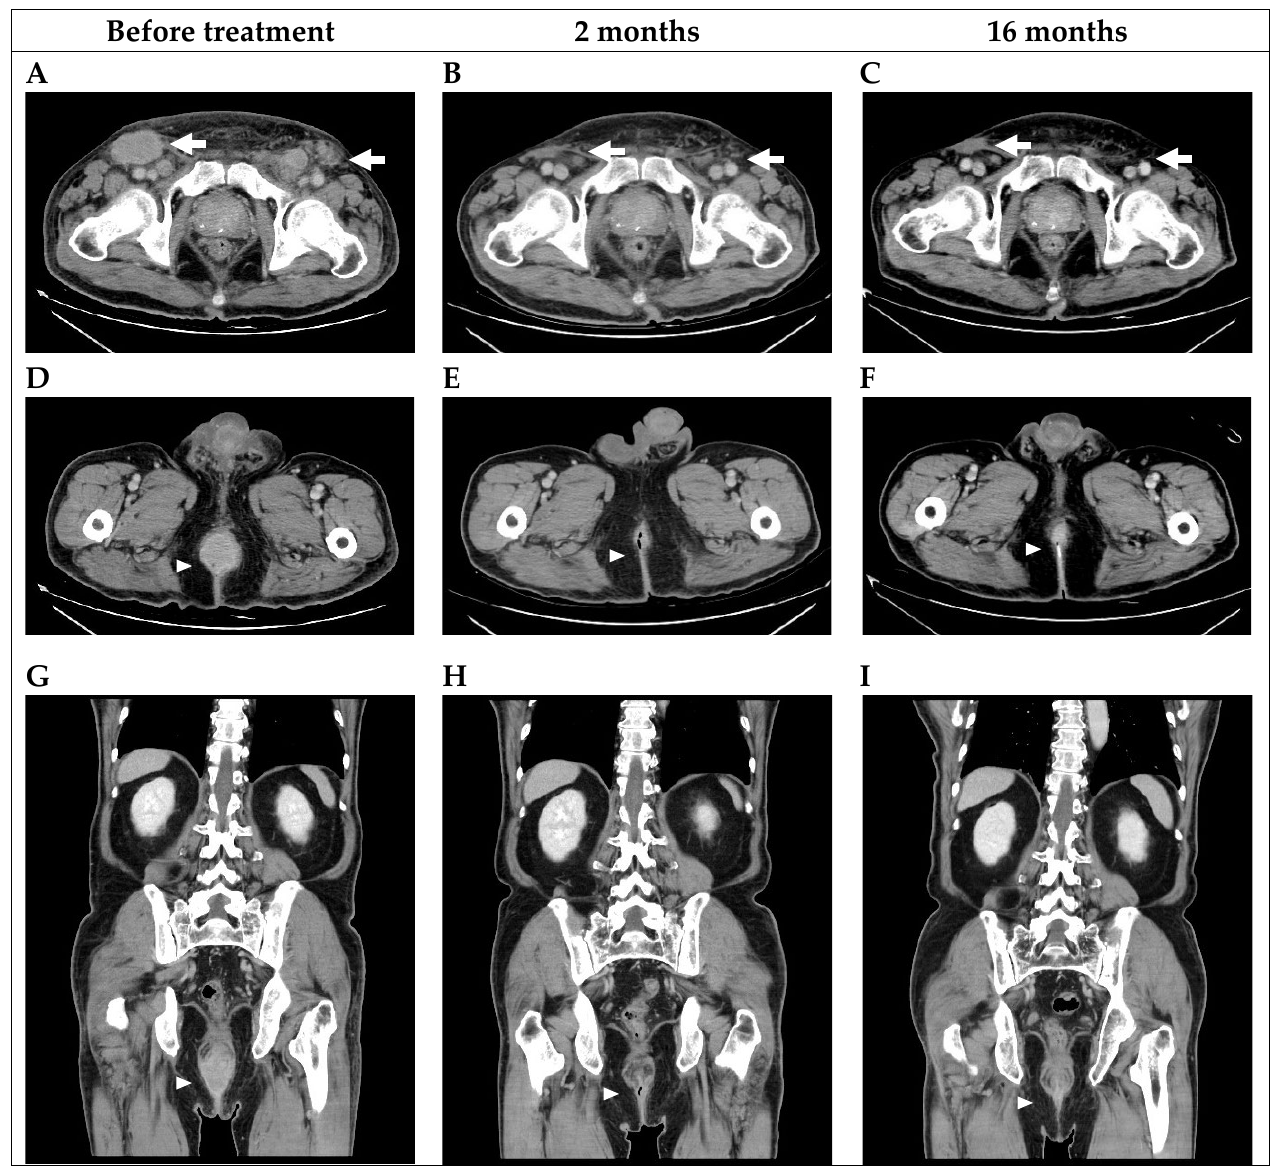
Figure 2. ( A – C ) Bilateral inguinal lymphadenopathy. Arrows: The bulky bilateral inguinal lymph nodes shrank 2 months after the combination treatment of durvalumab and chemotherapy. The effect persisted at 16 months. ( D – F ) Axial view of the rectal mass. ( G – I ) Coronal view of the rectal mass. Arrowhead: The rectal mass protruding from the anus shrank 2 months after combination treatment, and a complete response was noted at 16 months.